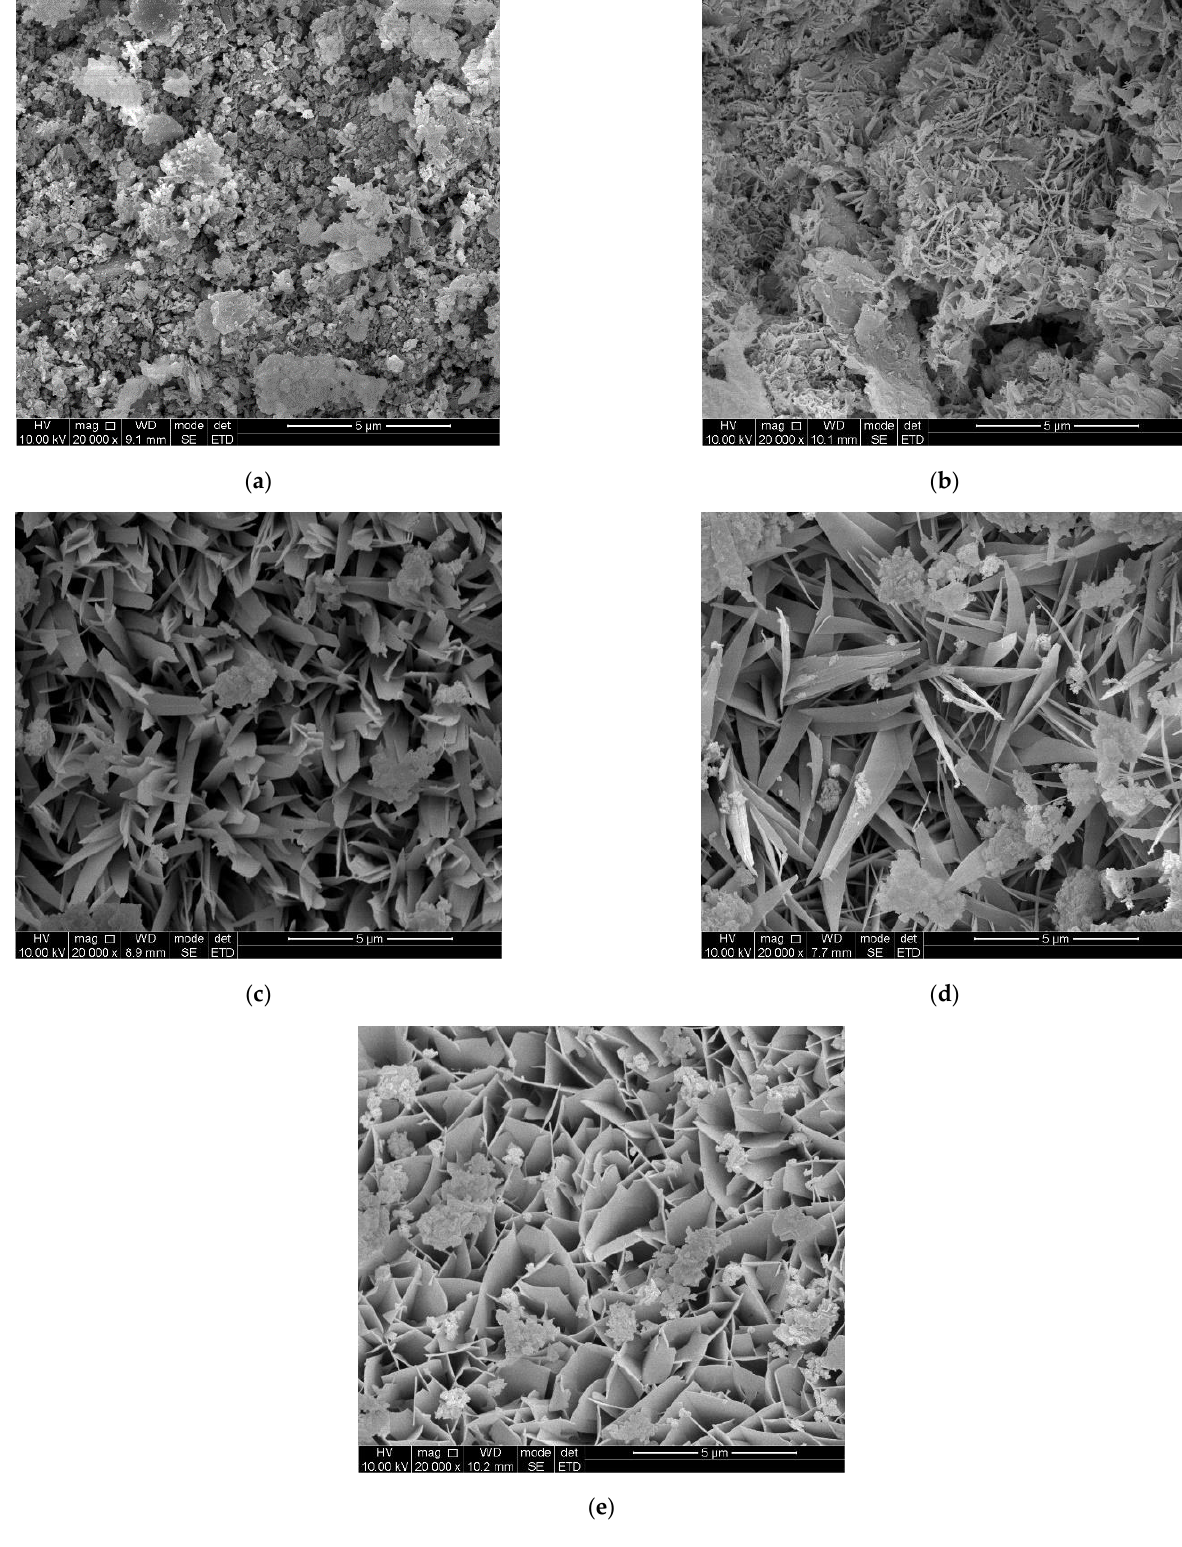
Figure 5. Hydration products of AAC and base material: ( a ) base material; ( b ) B04 AAC; ( c ) B05 AAC; ( d ) B06FA AAC; ( e ) B06S AAC.